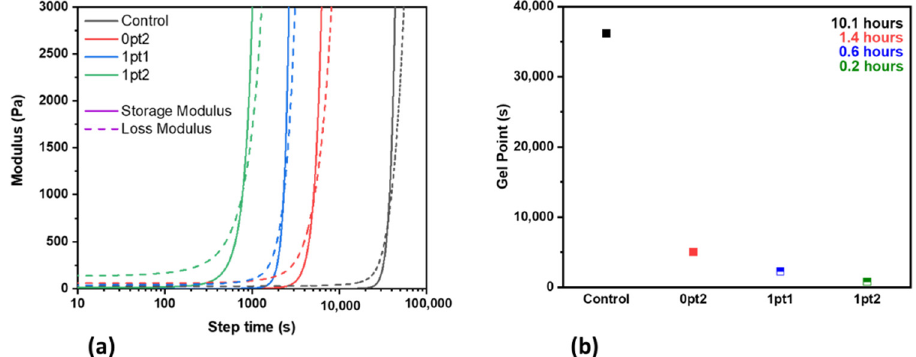
Figure 1. Rheology of the four formulations: ( a ) Storage and loss moduli, and ( b ) Gel point.